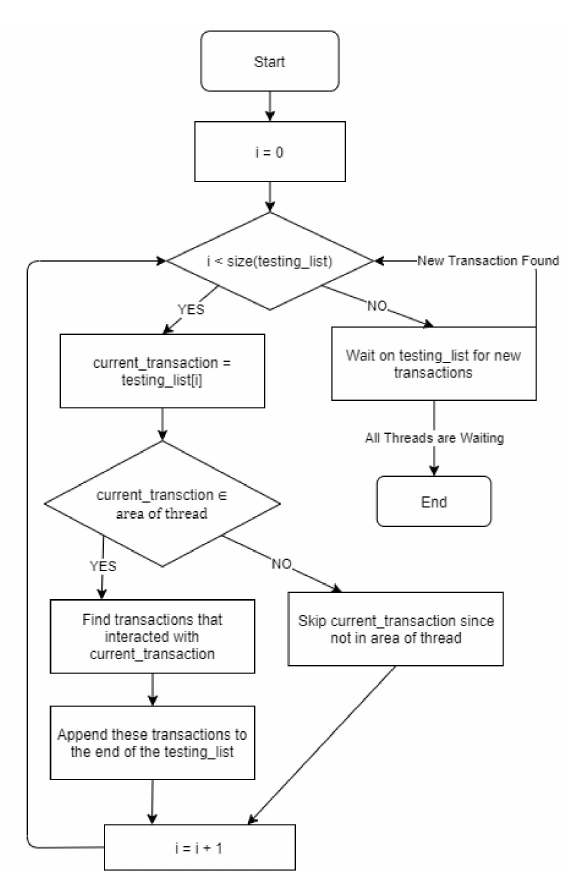
Figure 1. A flowchart for the above